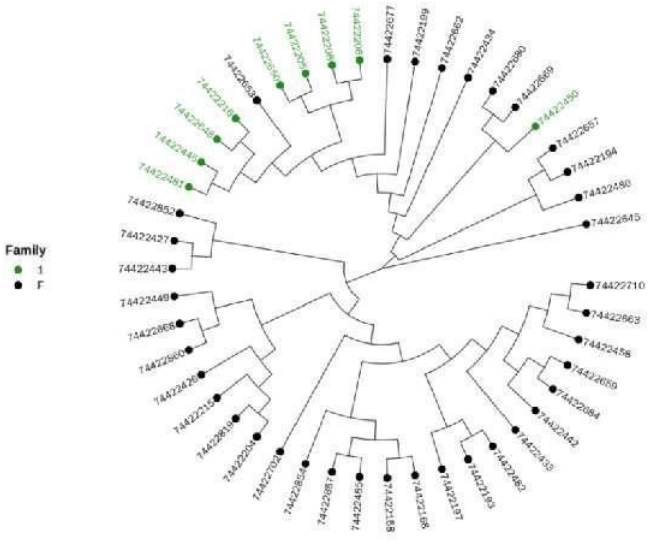
Figure 10. Clustering analysis results of all samples. Note: the color marked in the evolutionary tree is the bull sample, and one color represents a family.